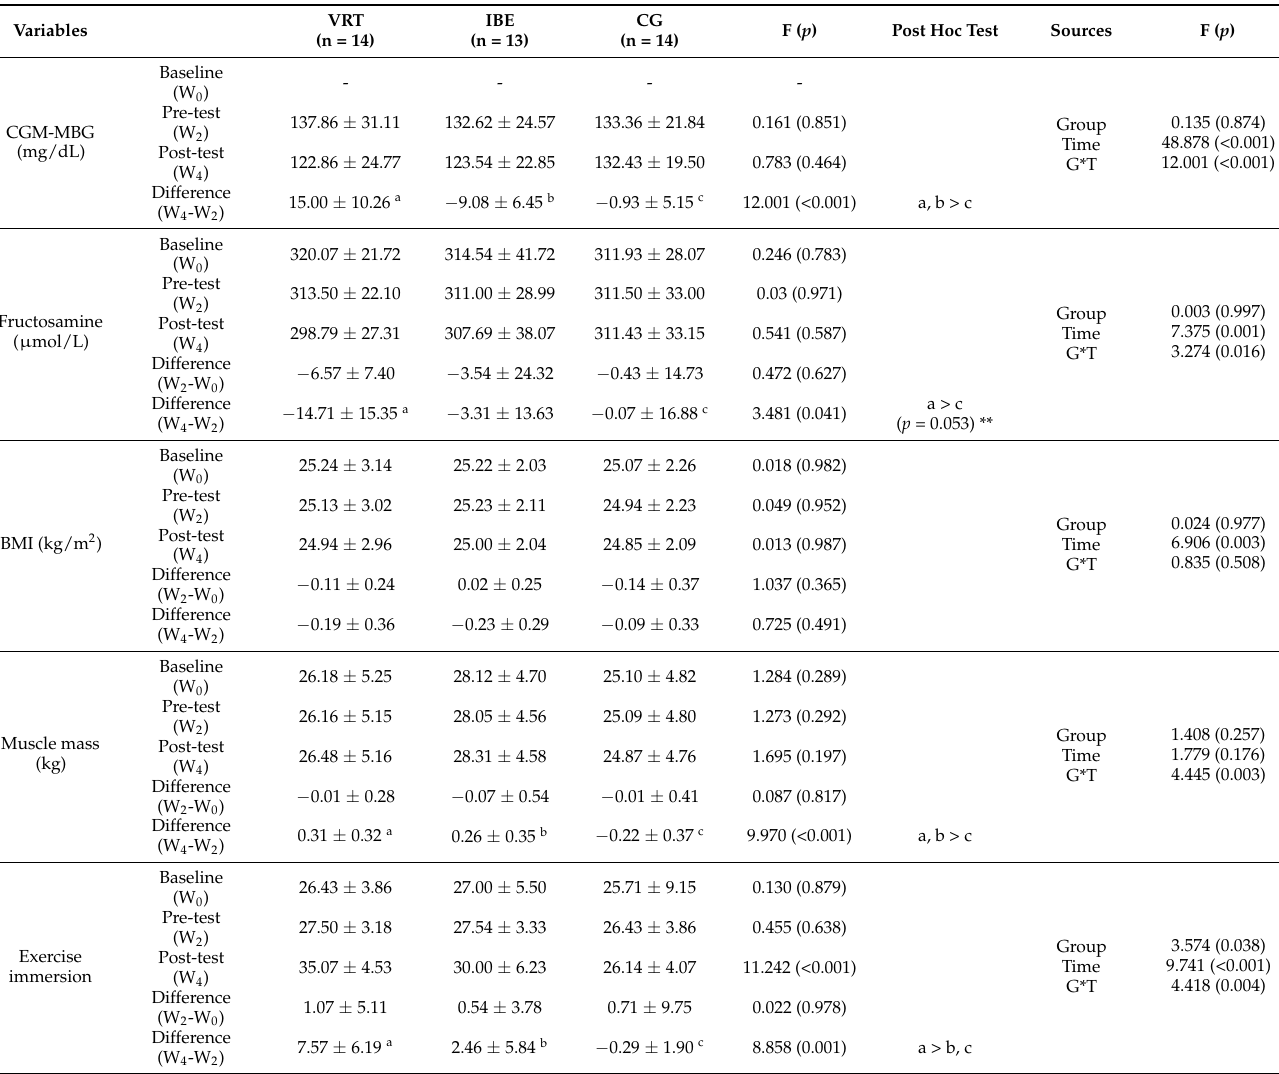
Table 2. Comparison of blood glucose, body composition, and exercise immersion between the groups (N =